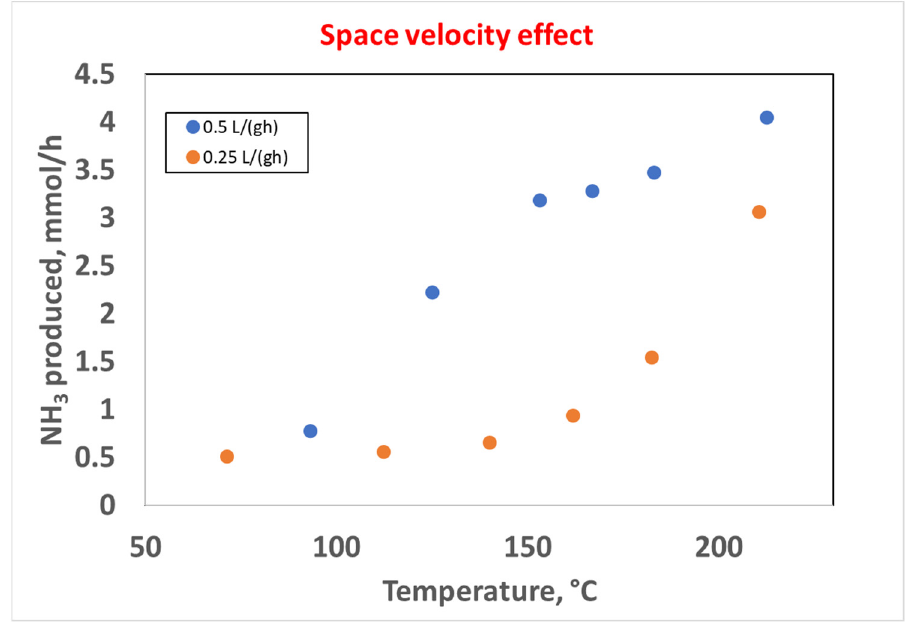
Figure 12. Effect of the space velocity on the catalytic activity in the 10Ni_zeolite 13X catalyst, space velocities of 0.5 L (g cat h) − 1 (blue curve) and 0.25 L (g cat h) − 1 (orange curve), H 2 :N 2 = 3.